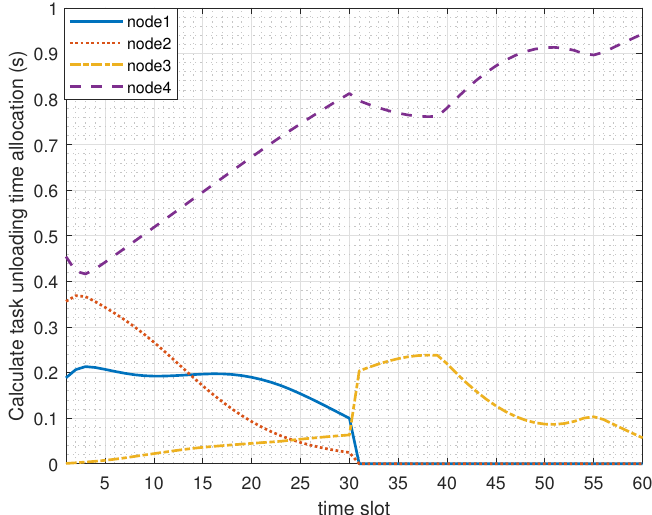
Figure 4. Time scheduling curve of each user in each time slot.